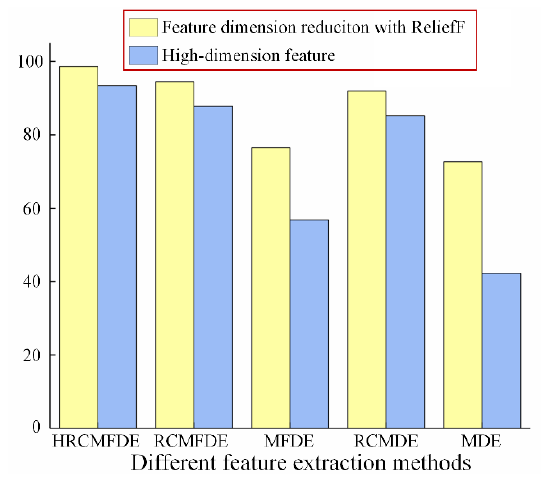
Figure 14. Comparison of identification accuracy before and after ReliefF. Table 4. The performance comparison between different methods without ReliefF.